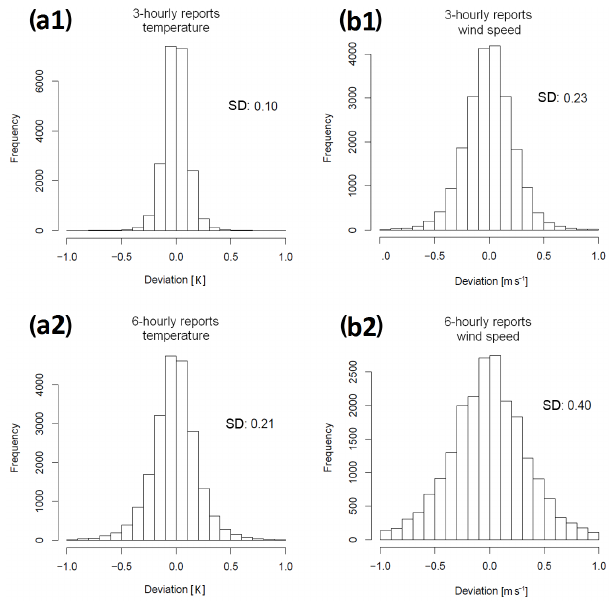
Figure 2. Accuracy of daily mean temperatures (a1, a2) and daily mean wind speeds (b1, b2) in January 2001 for different frequencies of observation (3 and 6h) using 1-hourly data as reference. The standard deviations, denoted SD, are added to the